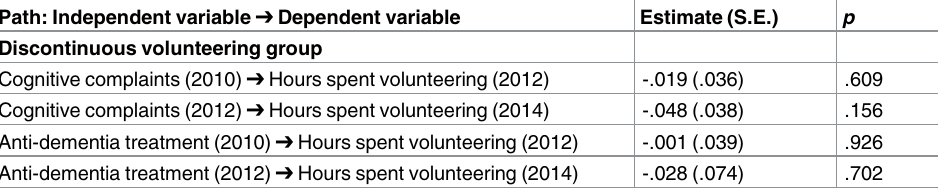
Table 3. Standardized coefficients of the reverse causation path model: Paths from cognitive com- plaints and anti-dementia treatment (2010 & 2012) to hours of voluntary work (2012 & 2014). Path: Independent variable ➔ Dependent variable Estimate